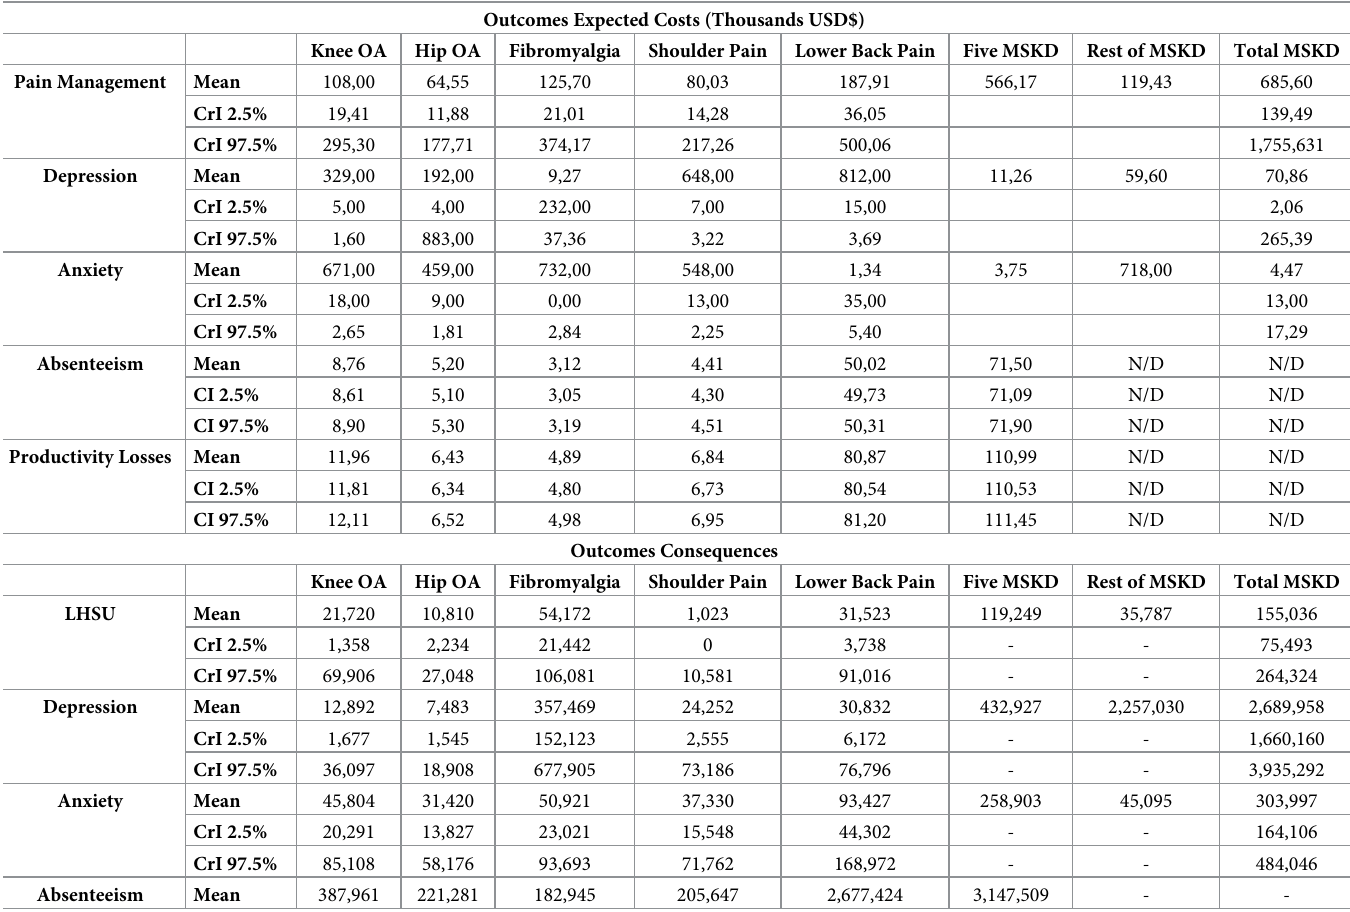
Table 2. Cost and consequences according to each health